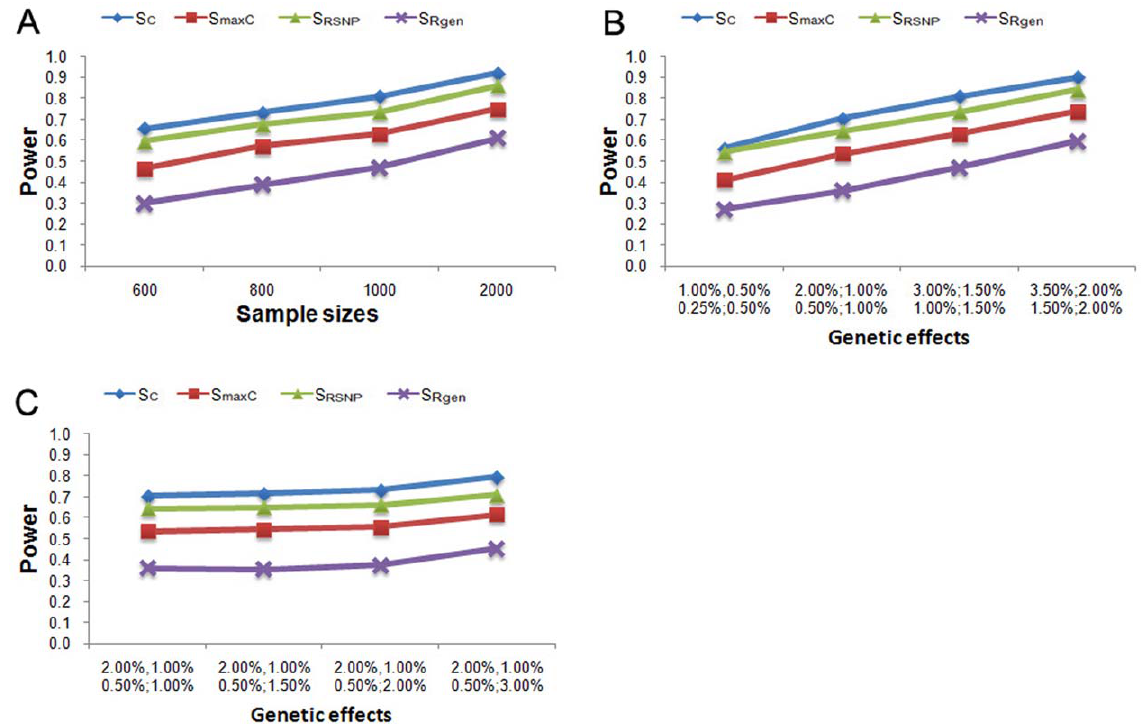
Figure 1. Power simulating results of PCA-based MPPAS using S C , S max C , S Rgen and S RSNP statistics under various sample sizes (A) and genetic effects(B&C).